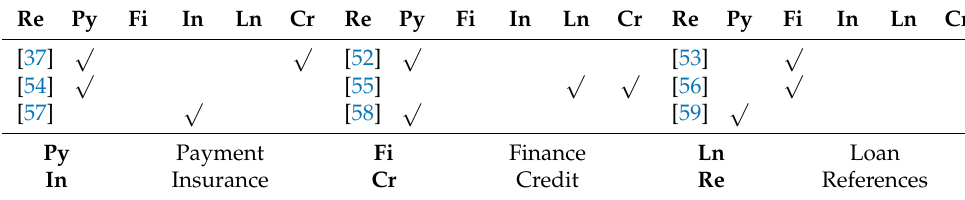
Table 4. Application of blockchain in agriculture for